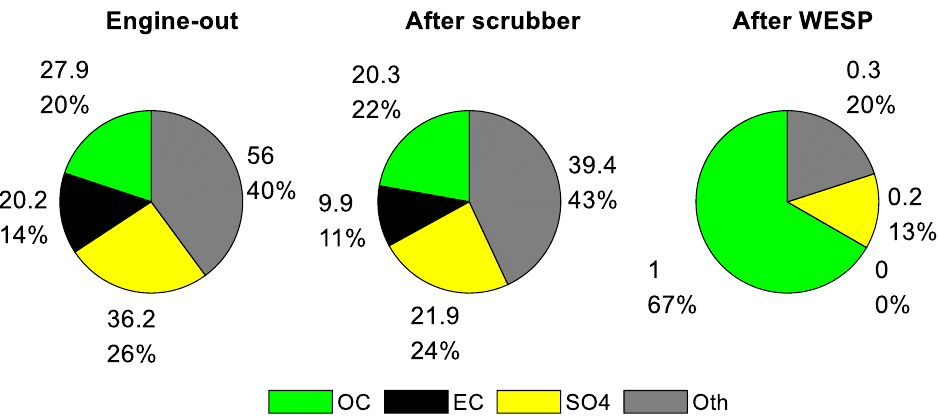
Figure 4. Mass composition of filter samples. OC refers to organic carbon, EC to elemental carbon, SO 4 to sulfate and Oth to other compounds. The upper value is the concentration in mg/m 3 and the lower value the ratio of compound to the total mass in percentage. The results were acquired with an engine load of 50% with HFO.